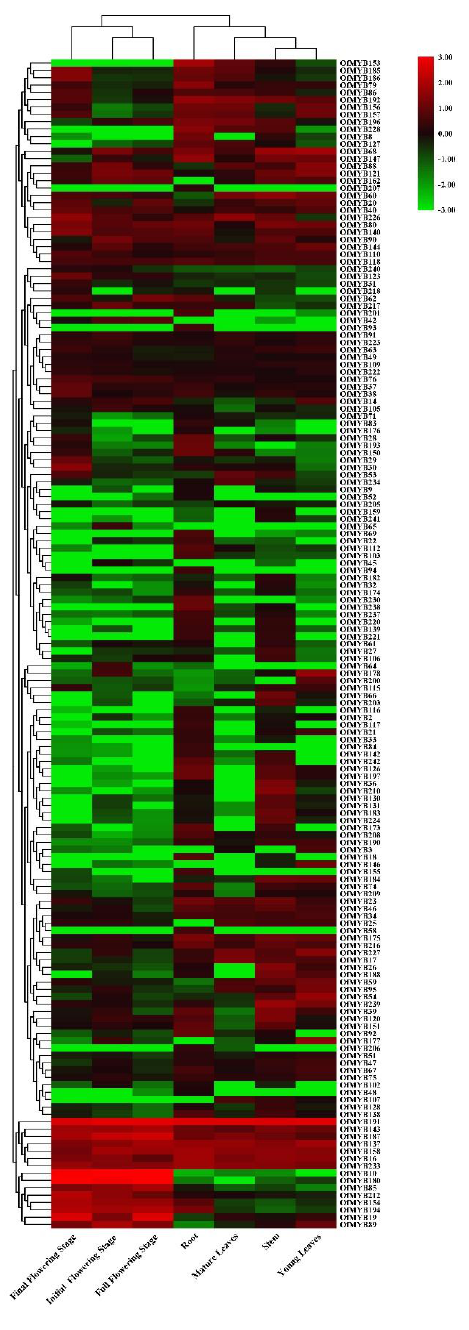
Figure 3. Heatmap of the expression level of sweet osmanthus 2R-MYB genes in tested tissues. The color scale at the right of the dendrogram represents log10 expression values. Red and green colors indicate higher levels and lower levels, respectively.